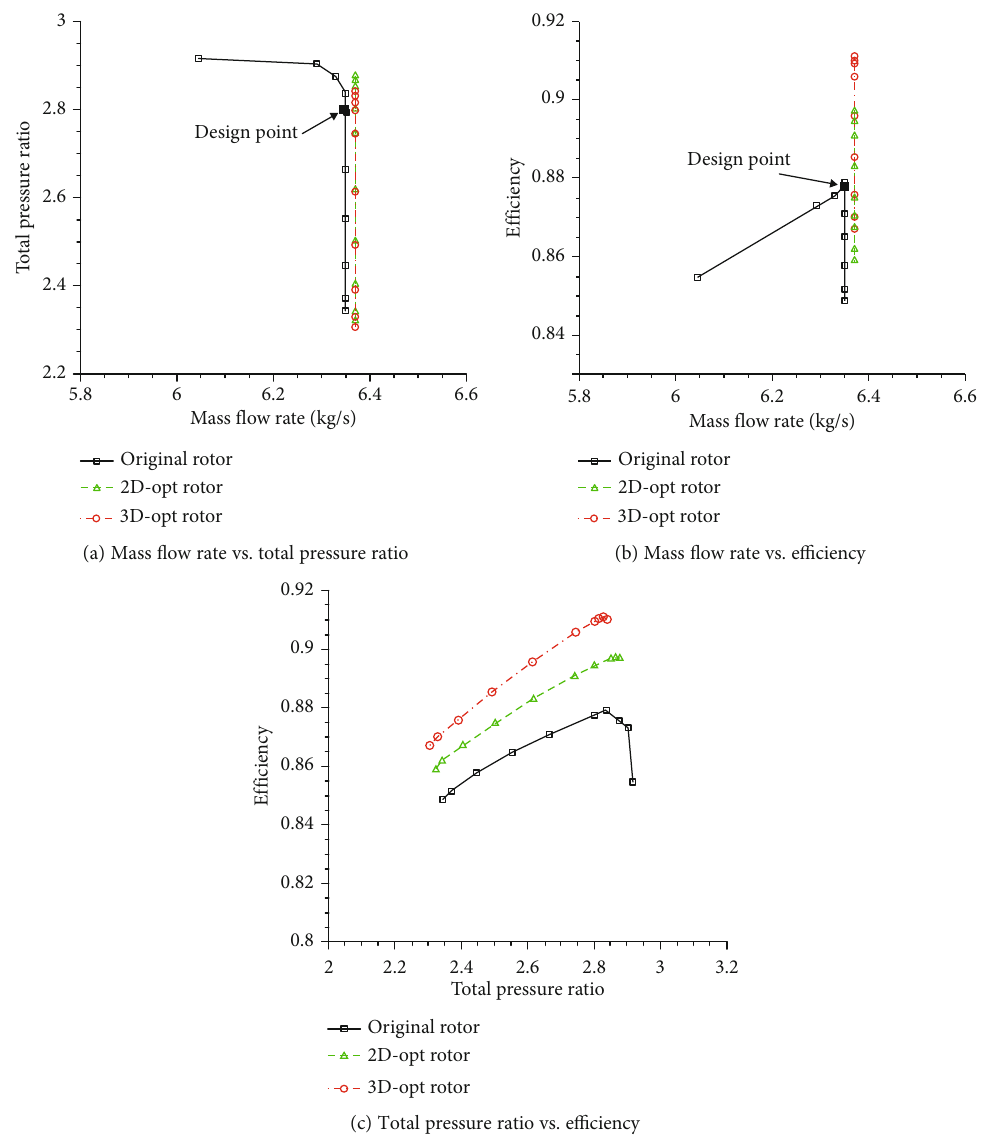
Figure 8: Performance curves for the three